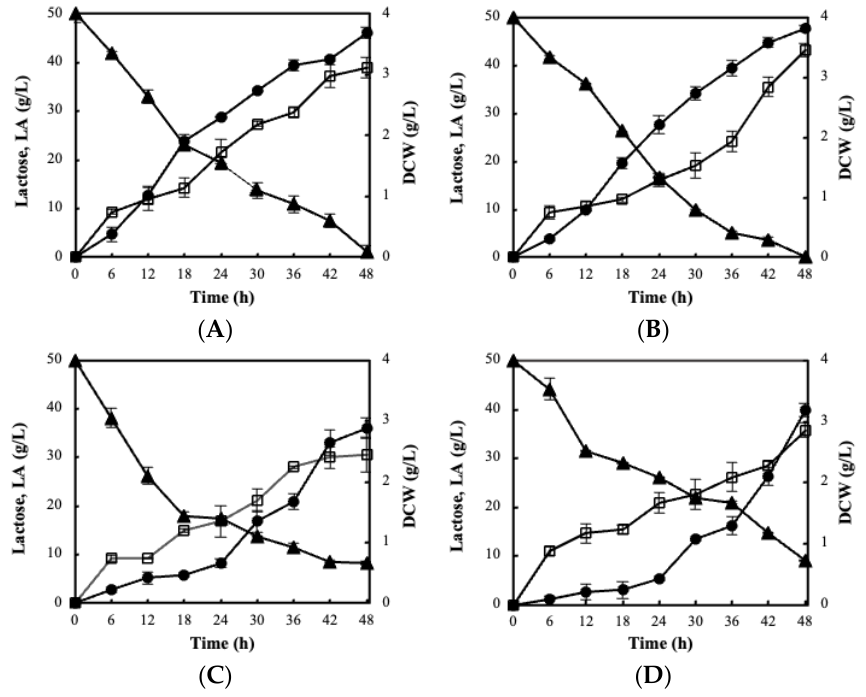
Fig. 1 . Profile change of (□) dry cell weight (DCW), (●) lactic acid (LA) , and ( ▲ ) lactose of L. pentosus B329 ( A ) and L. plantarum 820 ( B ) wet cultures, L. pentosus B329 ( C ) and L. plantarum 820 ( D ) freeze-dried cultures during CWP fermentation of ~50 g/L initial lactose concentration at 37 °C.